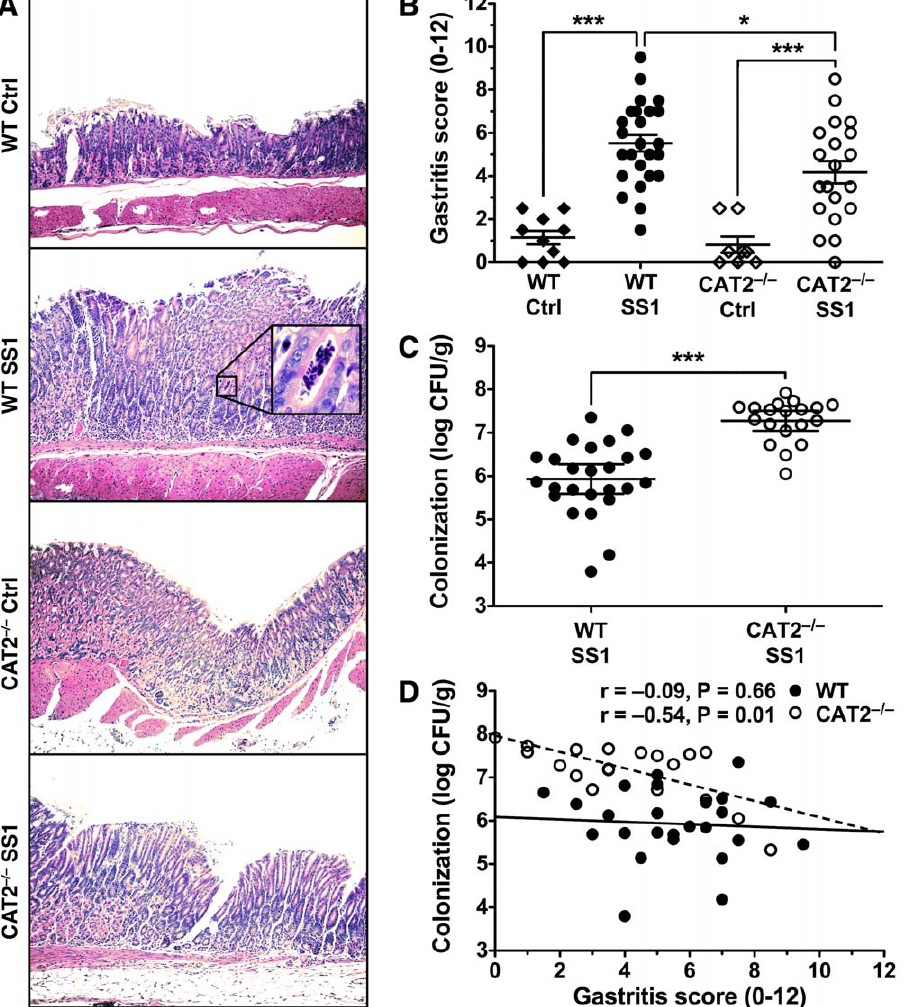
Figure 1. H.pylori -infected CAT2 2 / 2 mice display less gastritis and increased gastric colonization. Wild type (WT) and CAT2 2 / 2 mice were infected with H. pylori SS1 and sacrificed after 4 months. (A) Strips of stomach tissue containing both the body and the antrum were sectioned, mounted, and stained with hematoxylin and eosin. Representative sections of the antrum/body transition zone for each treatment group. Images were captured at 100 6 with the inset demonstrating a gland infiltrated with neutrophils (crypt abscess) at 600 6 . (B) Inflammation was scored on a 0– 12 scale. Each point represents a single mouse ( n =8–25 per group). (C) In each H. pylori -infected mouse colonization levels were determined by quantification of colonies cultured from a piece of gastric body that was homogenized, diluted, and plated on selective medium. Each point represents a single mouse ( n =19–25 per group). (D) Colonization was plotted against gastritis score for each infected mouse. The lines illustrate the best-fit linear regressions obtained for the two strains of mice with the correlation coefficient and significance as indicated. In panels B and C, *, p , 0.05; ***, p , 0.001 for comparisons indicated.